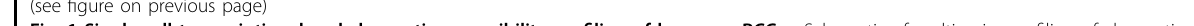
Fig. 1 Single-cell transcriptional and chromatin accessibility pro fi ling of human ccRCC. a Schematic of multiomics pro fi ling of chromatin accessibility and transcription in ccRCC using scRNA-seq and scATAC-seq. b scRNA-seq UMAP projection of 38,097 single cells from four ccRCC samples. c Dot plot showing the gene expression patterns of cell-type marker genes in the scRNA-seq data. d Cross-platform linkage of scATAC-seq cells with scRNA-seq cells. e scATAC-seq UMAP projection of 21,272 single cells from three ccRCC samples. f Normalized chromatin accessibility pro fi les for each cell type at canonical marker genes. The promoter region is highlighted in gray with the gene model and chromosome position shown below. g Heatmap of CNV signals normalized against the “ normal ” cluster shown in the top panel (CD8 + T cells and NK/NKT cells) for CNV changes by chromosome (columns) within individual cells (rows). All cells in the tumor population (bottom panel) exhibited chromosome 3p loss (blue dotted frame) or chromosome 5q gain (red dotted frame), which are classic genomic features of ccRCC. h Pie charts of the proportion of each class in the scRNA-seq and scATAC-seq